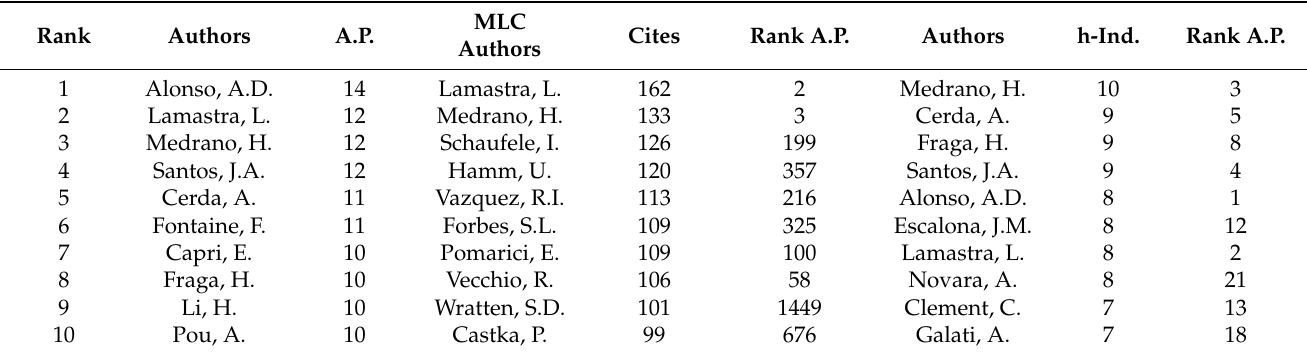
Table 3. Classification of the leading authors in terms of number of publications, citations, and h-index.